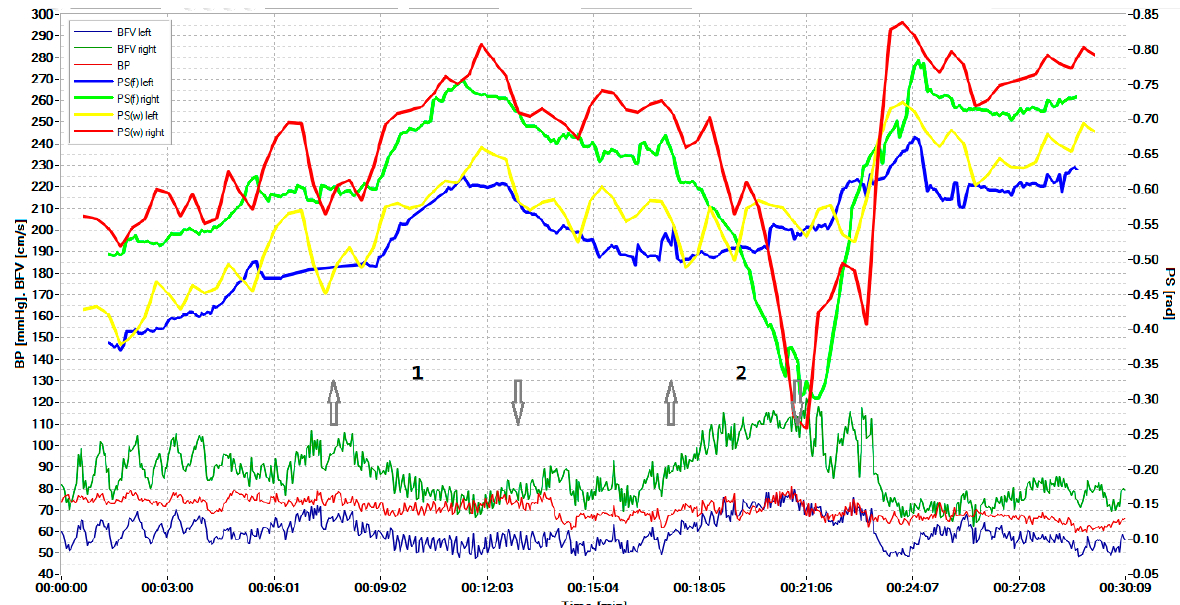
Figure 5. Simultaneous monitoring of the cerebral, systemic hemodynamics, and the state of the CA in a 73 ‐ year ‐ old patient with critical stenosis of the internal carotid artery. The arrow pointing up indicates the beginning of the hypercapnic test (1), while the arrow pointing down indicates its end. Similarly directed arrows indicate the beginning and end of the hypocapnic test (2).